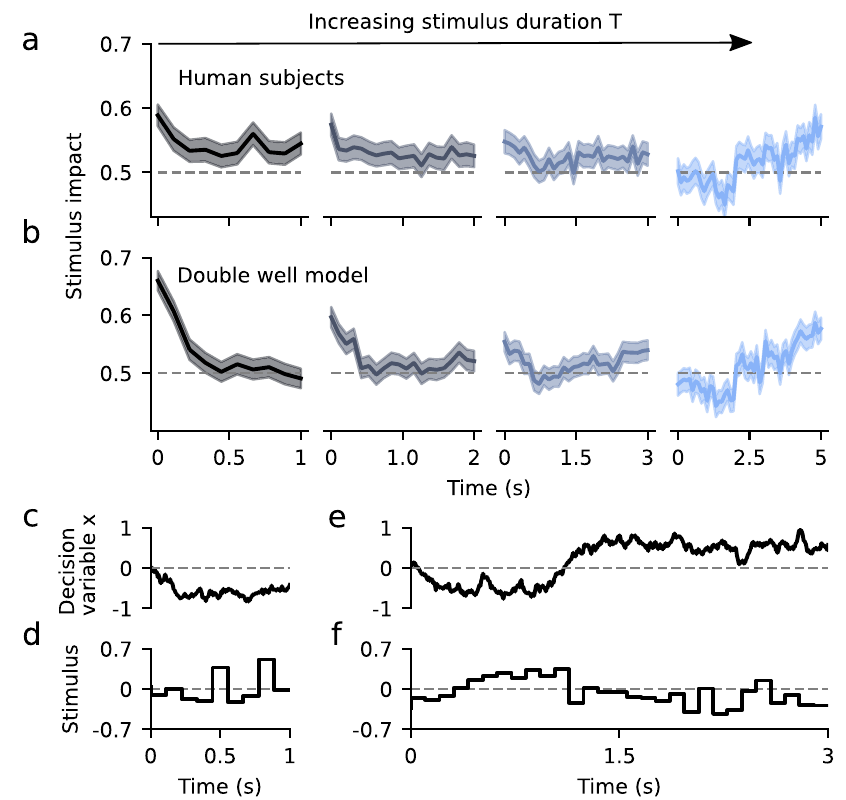
Fig. 6 The double well model accounts for experimentally observed changes in psychophysical kernels. a Psychophysical kernels for different stimulus durations, obtained from human subjects performing a brightness discrimination task ( N = 21) 34 . From left to right, stimulus duration was T = 1, 2, 3, and 5 s. b Psychophysical kernels obtained by fi tting the DWM to categorize the very same stimuli presented to the human subjects (i.e., same temporal fl uctuations of net evidence; see Methods). Lines represent the kernels obtained from pooling all data across subjects and the error bands represent s.e.m. c – f Example traces of the decision variable of the fi tted DWM ( c , e ) and the stimulus ( d , f ) for 1 and 3 s trials. Notice that the stimulus fl uctuations mimicked the visual stimulus which was made of time frames of 100